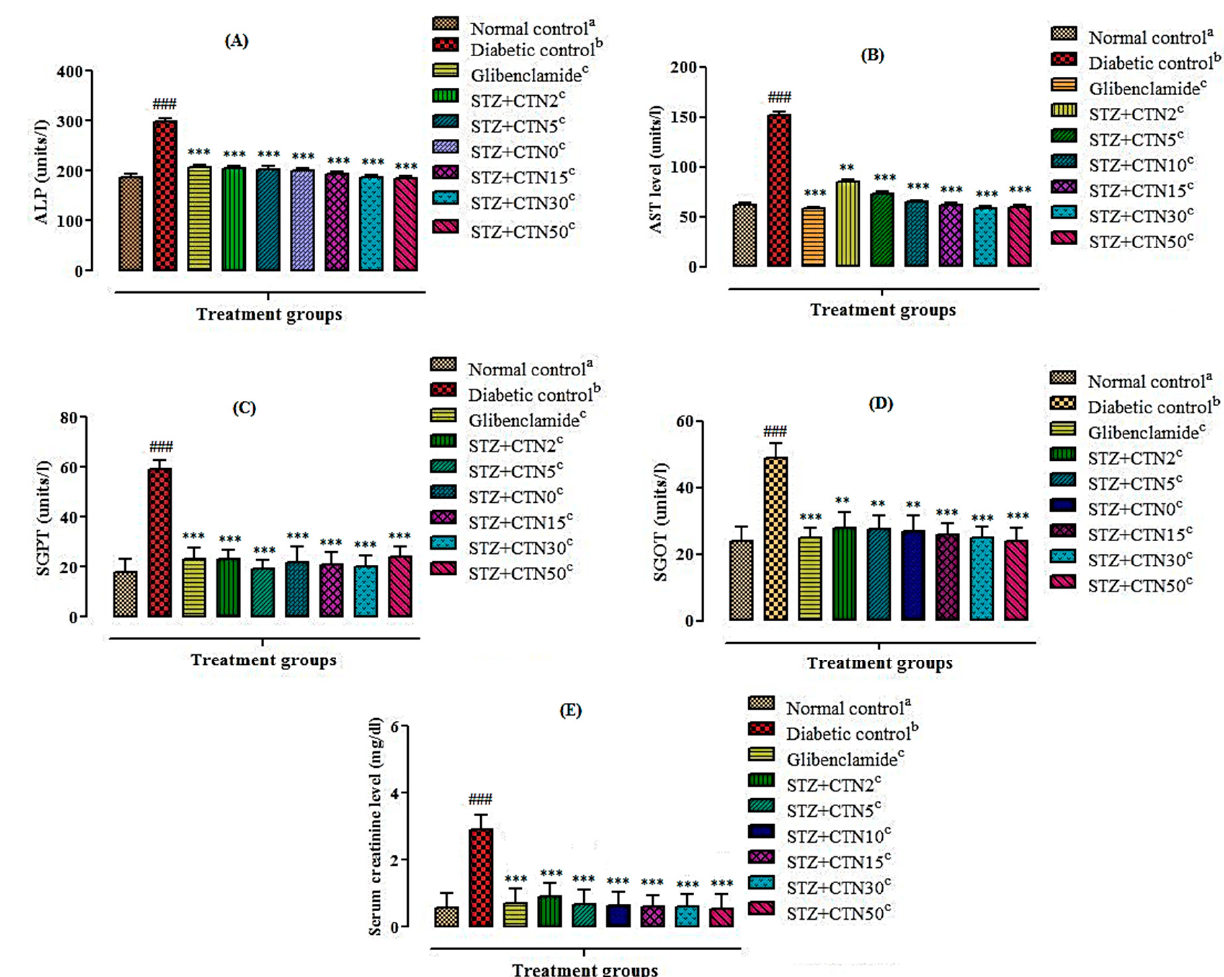
Figure 3. Effects of catechin on the level of liver serum biochemical parameters in STZ-induced diabetic rats: ( A ) Serum level of ALP, ( B ) serum level of AST, ( C ) serum level of SGPT, ( D ) serum level of SGOT, ( E ) serum level of creatinine in STZ-induced diabetic rats. The values are expressed as mean ± SEM. Each value corresponds to a mean of eight animals ### p < 0.001; comparison of a (normal control) vs. b (diabetic control) using Student’s t -test, ** p < 0.01, *** p < 0.001; comparison of b (diabetic control) vs. c (Glibenclamide and CTN treated groups) using one way ANOVA followed by Dunnett’s post hoc multiple comparison test.